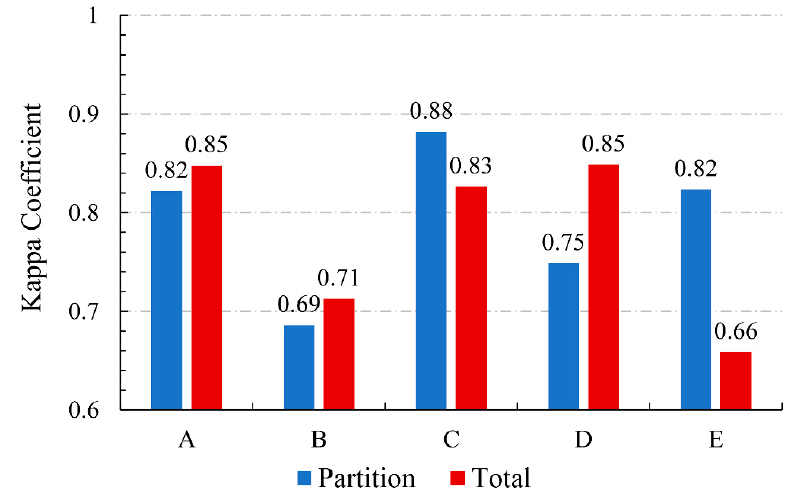
Figure 6. Accuracy of UV detection using samples of the individual and the total five zones.